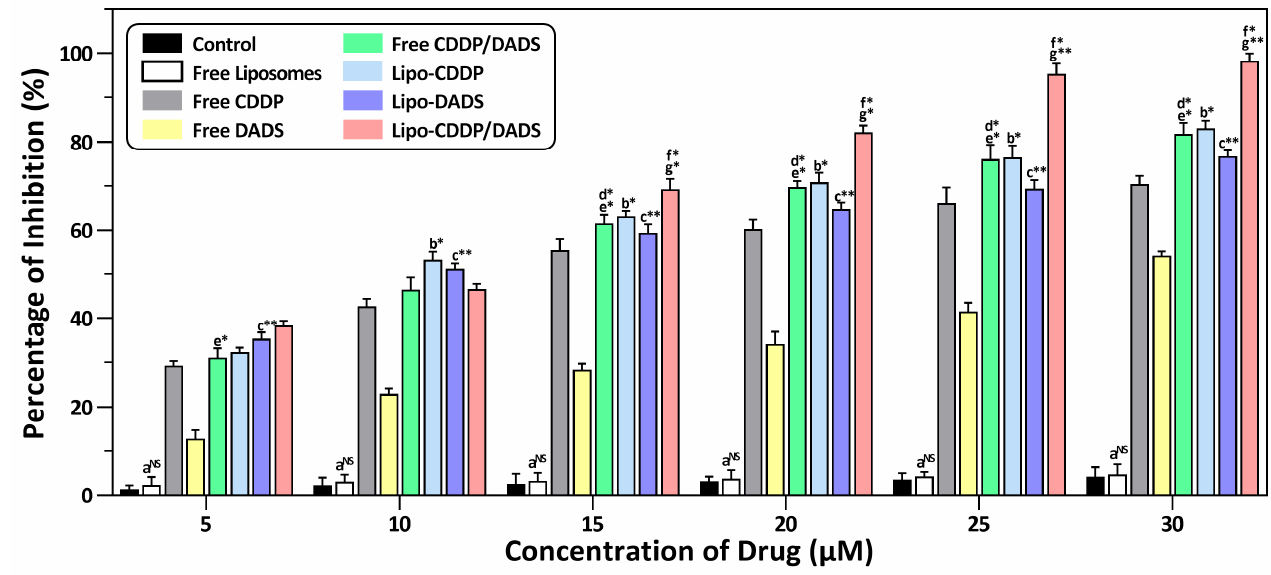
Figure 6. In vitro cytotoxic effect by control, free drugs, and drug(s)-loaded nanoliposomes on A549 cell line. Results are shown as mean ± standard deviation ( n = 3). Group a, control vs. free liposome; Group b, free CDDP vs. Lipo-CDDP; Group c, free DADS vs. Lipo-DADS; Group d, free CDDP vs. free CDDP/DADS; Group e, free DADS vs. free CDDP/DADS; Group f, Lipo-CDDP vs. Lipo- CDDP/DADS; Group g, Lipo-DADS vs. Lipo-CDDP/DADS. * p ≤ 0.05, signi fi cance; ** p ≤ 0.01, most signi fi cance; NS, non-signi fi cance. Table 4. IC 50 values for free and nanoliposomal drugs on cancer cells by MTT assay. No.